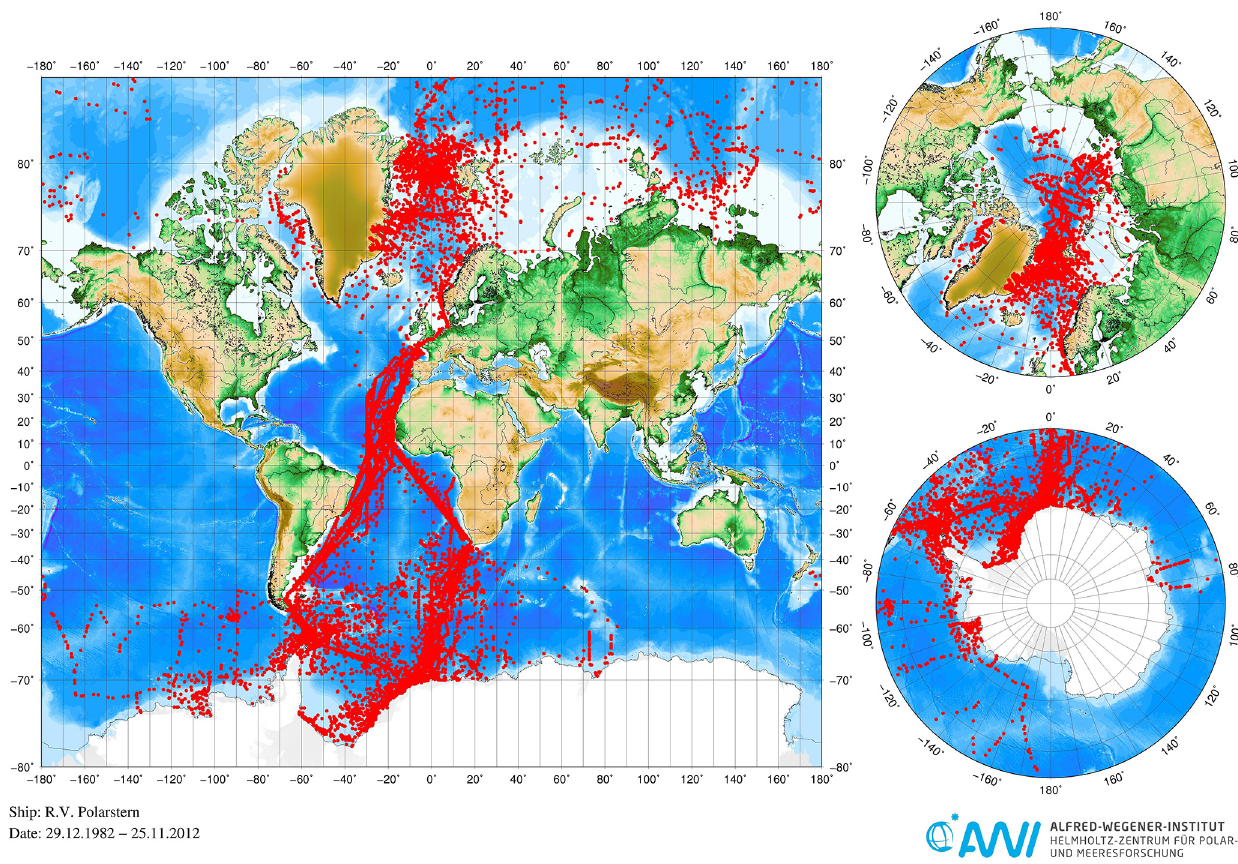
Figure 2. Map showing the locations of 30 years of radiosonde launches performed from POLARSTERN . From Antarctic cruise ANT-I/1 on 29 December 1982 until the end of ANT-XXIX/1, on 25 November